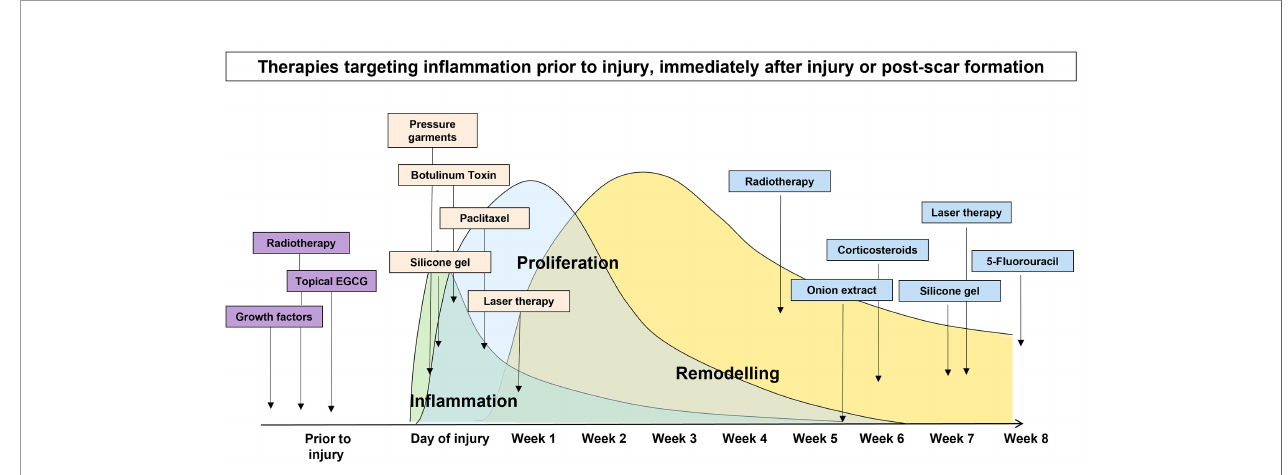
FIGURE 2 | Scar therapies which aim to target in fl ammation pre-emptively prior to injury, immediately after injury and post-scar